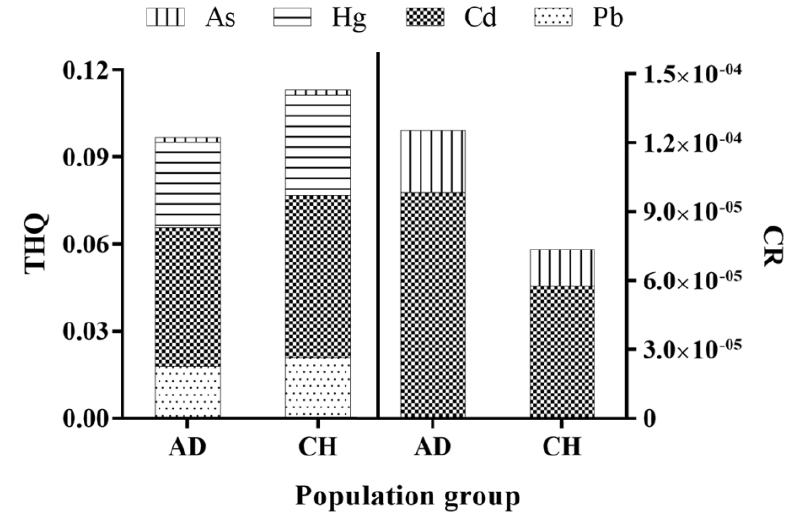
Figure 7. The results of human health risks (AD: adult, CH: children).